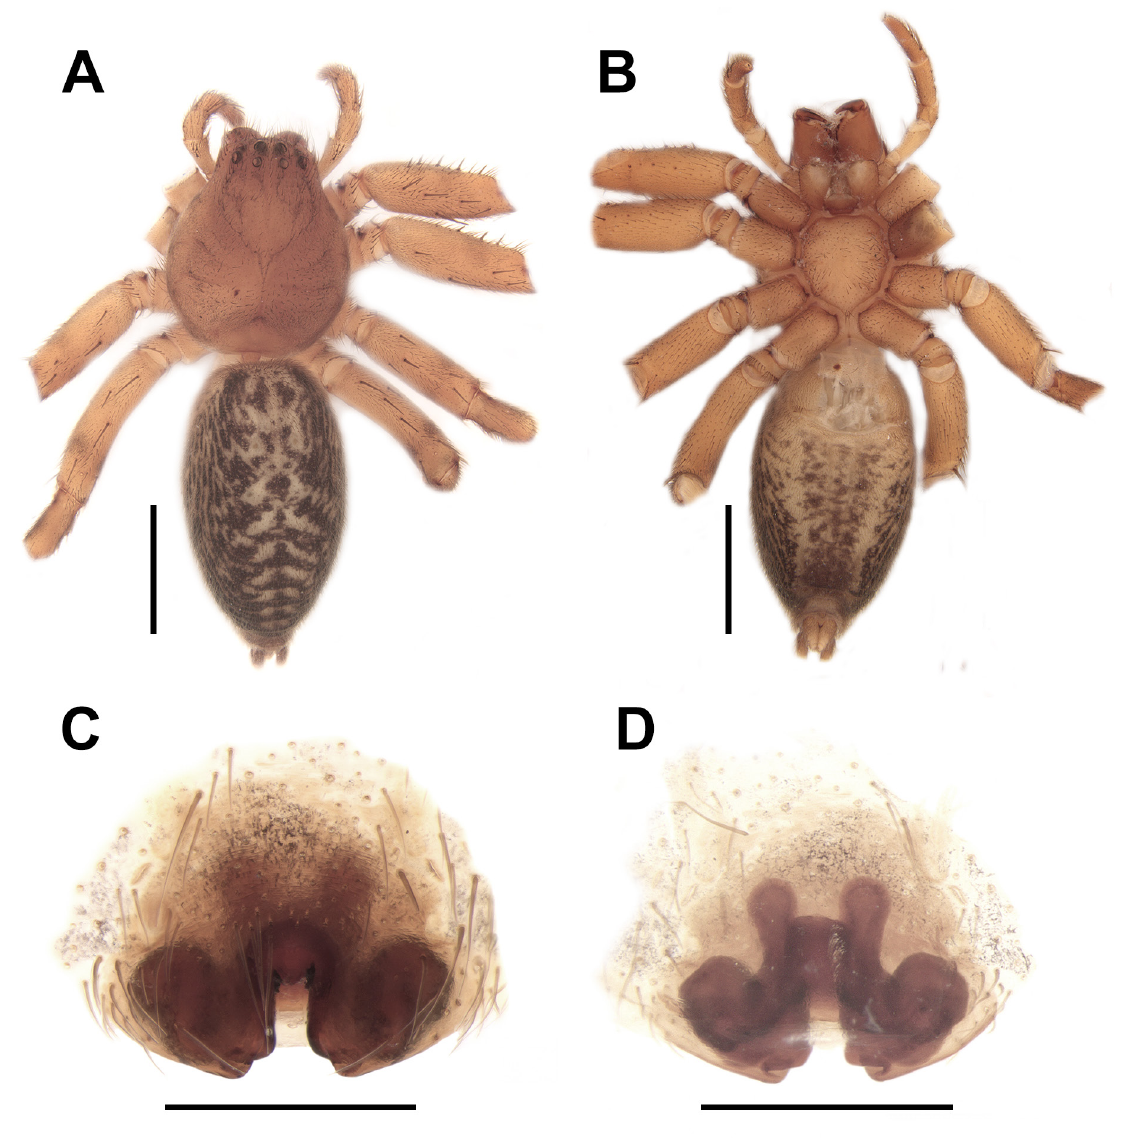
Fig. 6. Cuiambuca borborema sp. nov., holotype, ♀ (IBSP 60011). A . Habitus, dorsal view. B . Habitus, ventral view. C . Epigyne, ventral view. D . Vulva, dorsal view. A−B = 2.0 mm; C−D = 0.5